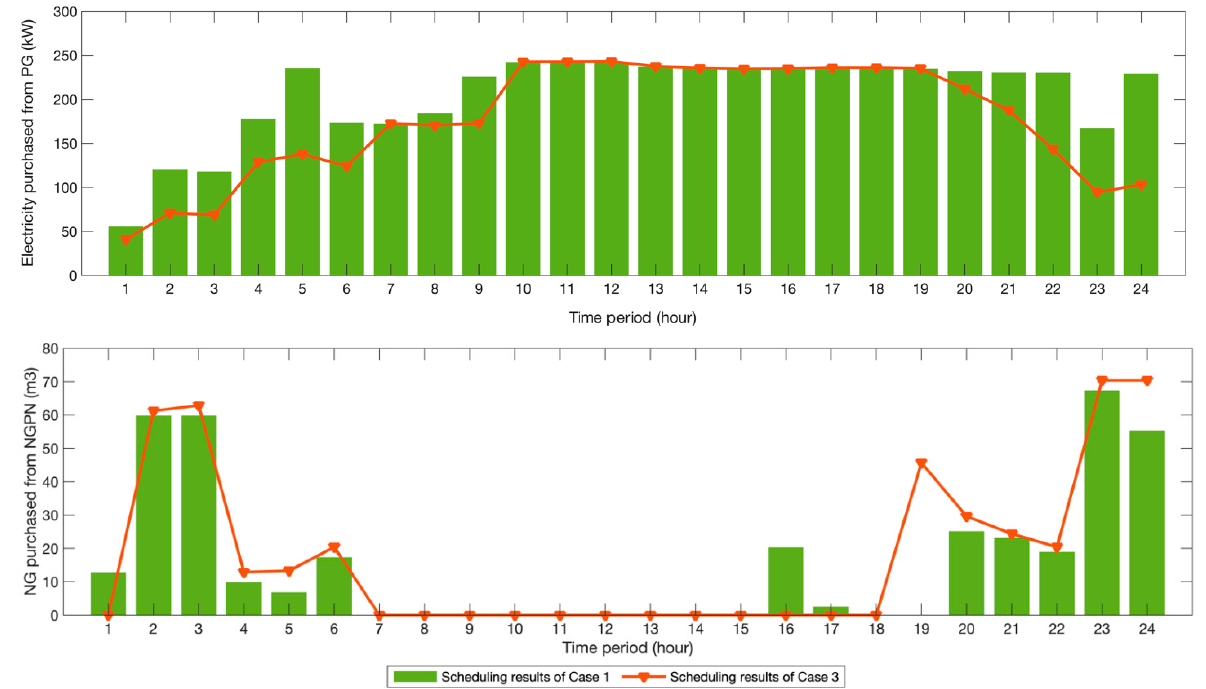
Figure 7. Purchases of NG and electricity in Cases 1 and Case 3.